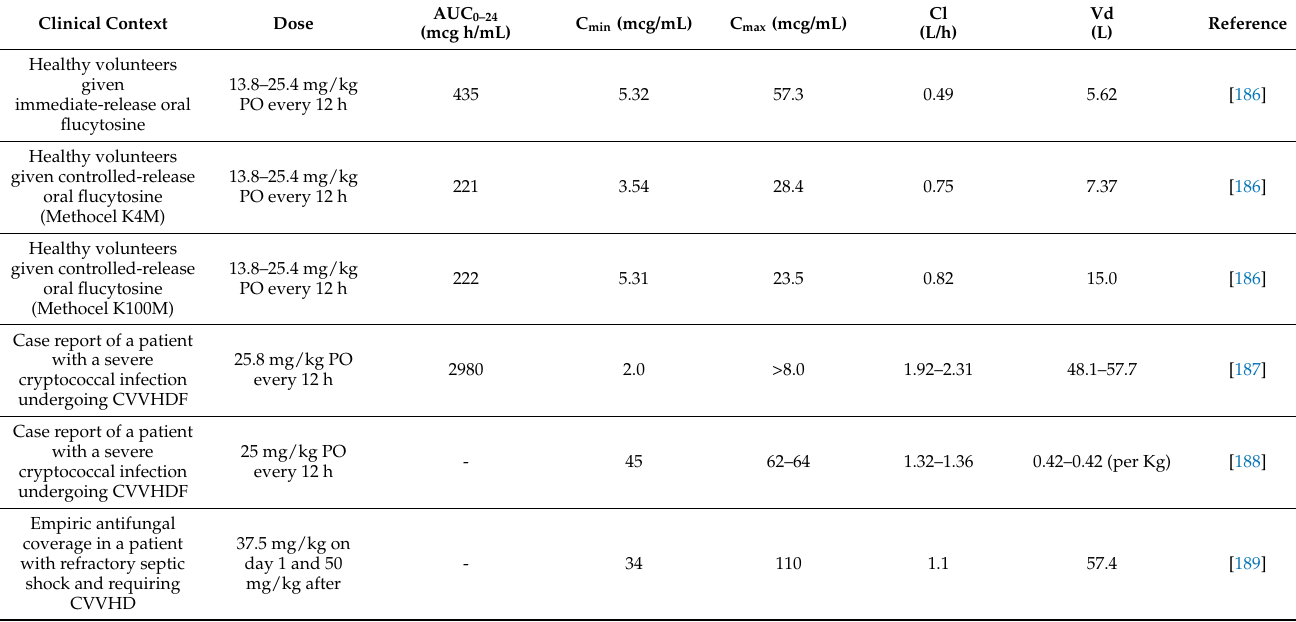
Table 7. Summary of Clinical Studies Assessing PK Parameters of Flucytosine in Healthy Volunteers and Patients with Cryptococcal